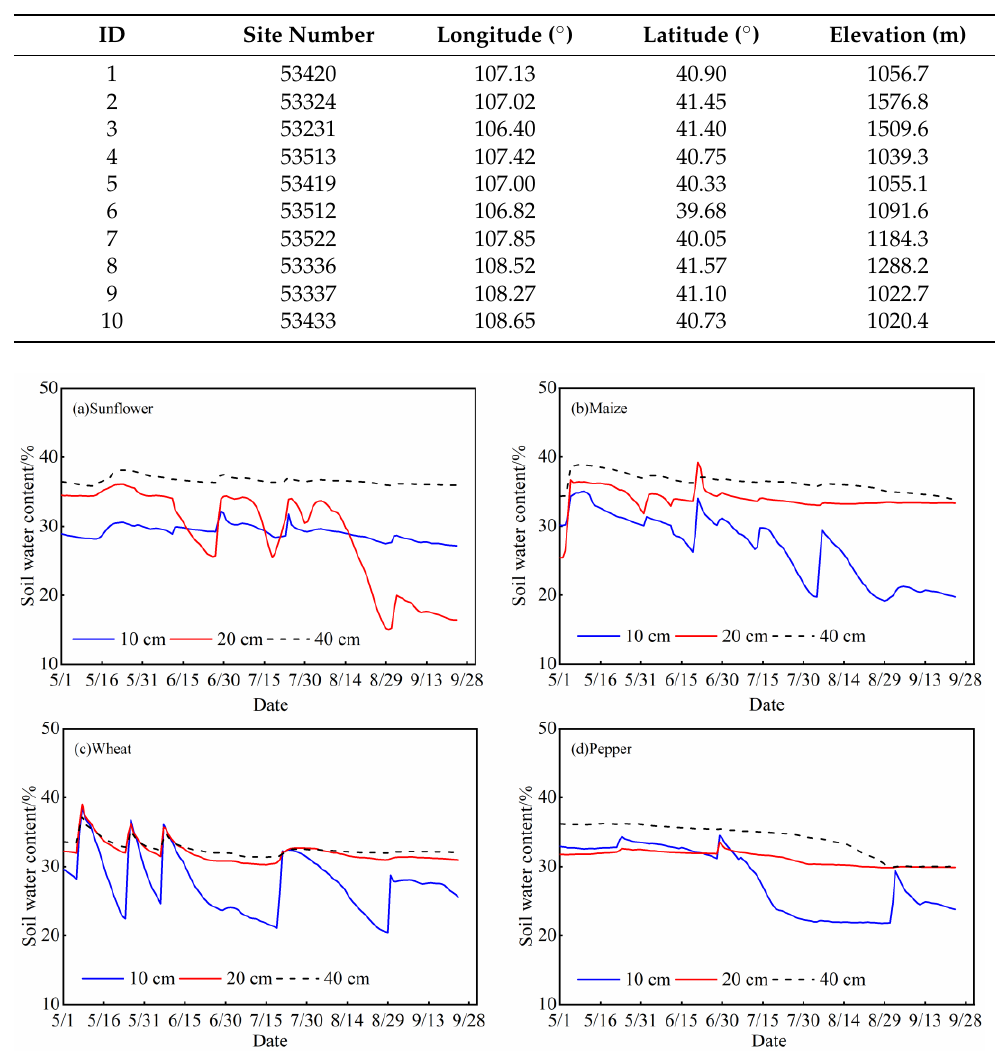
Figure 2. The measured SWC in the typical croplands in the Jiefangzha Irrigation Field. ( a ) Sunflower; ( b ) Maize; ( c ) Wheat; ( d ) Pepper.